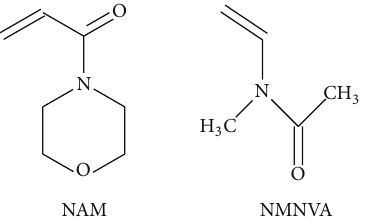
Figure 1: Monomers structures: N-acryloyl-morpholine (NAM) and N-methyl-N-vinylacetamide